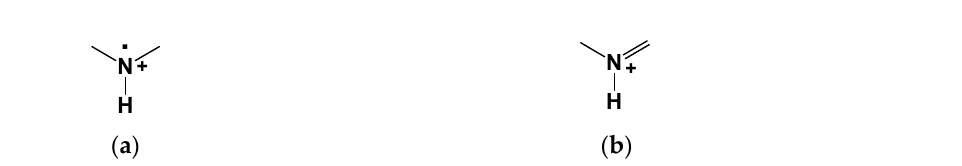
Figure 5. Schematic representation of: polaron species from SQ ( a ) and bipolaron species from SQ ( b ).